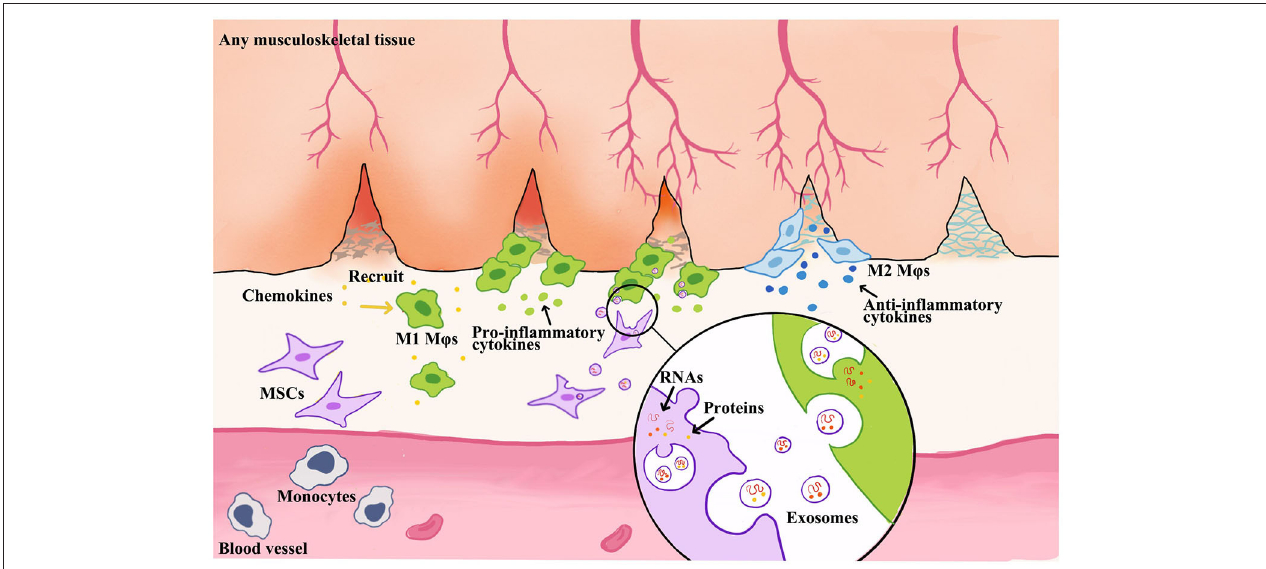
FIGURE 3 | Schematic illustration of MSC-derived exosome-guided macrophage reprogramming. MSC-derived exosomes can induce a conversion of M1 to M2 M ϕ s and accelerate musculoskeletal tissue healing. M ϕ s could be activated by inflammatory chemokines and then to produce proinflammatory factors. This creates a feedback loop whereby proinflammatory cytokines produced by M ϕ s stimulate MSC to produce immune modulators, such as exosomes or EVs. Therefore, the formation of exosomes begins with membrane invagination in the form of endosomes, leading to the development of the early endosomes. Upon maturation, the endosomes become multivesicular endosomes, which release their contents in the form of exosomes.